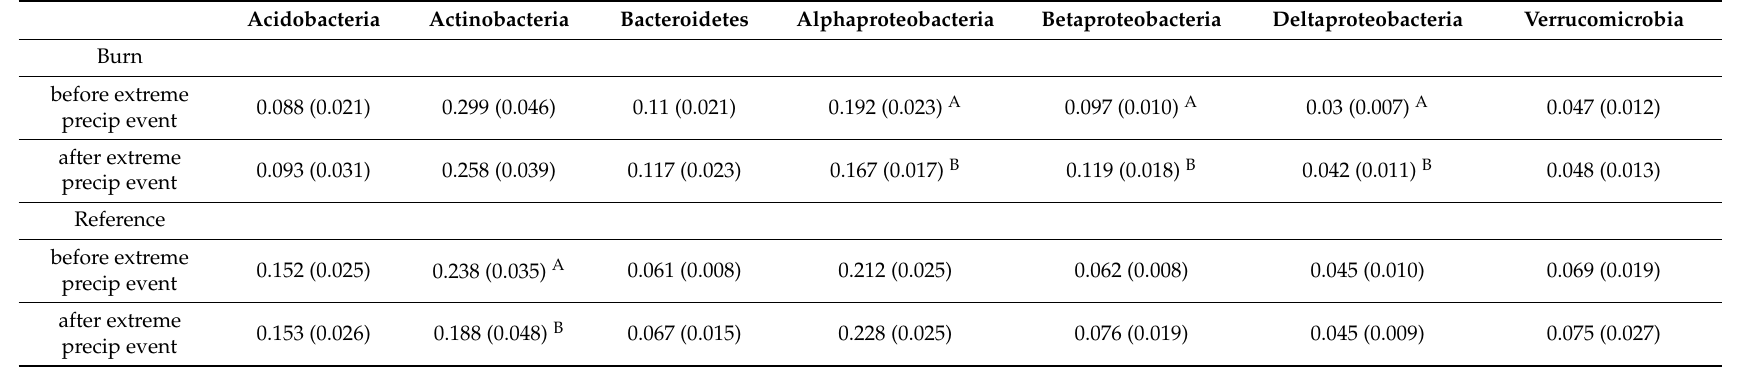
Table 3. Bacterial phyla relative abundance means and standard deviation for both burned and reference forest soils, before and after the extreme precipitation